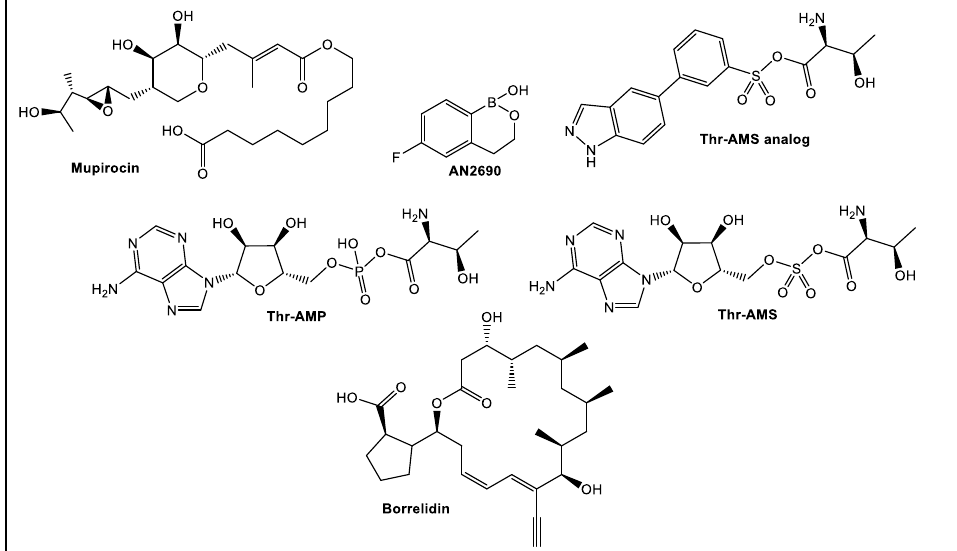
Figure 22. The intermediate product Thr-AMP of ThrRS. Representative inhibitors of ThrRS in the nanomolar range.